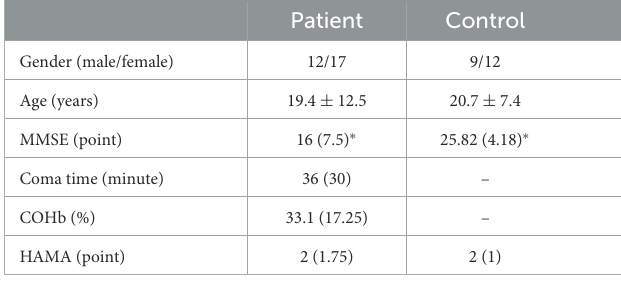
TABLE 1 Participant clinical